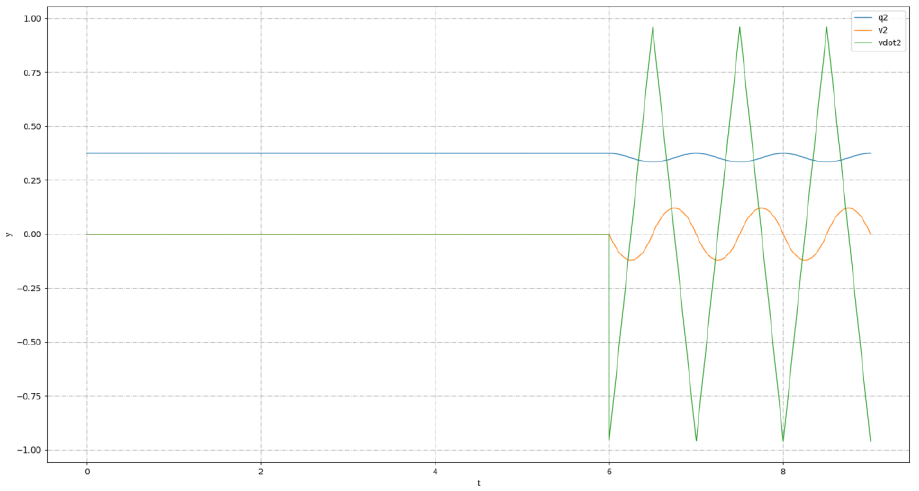
Figure 4. Planned COM motion trajectory diagram.